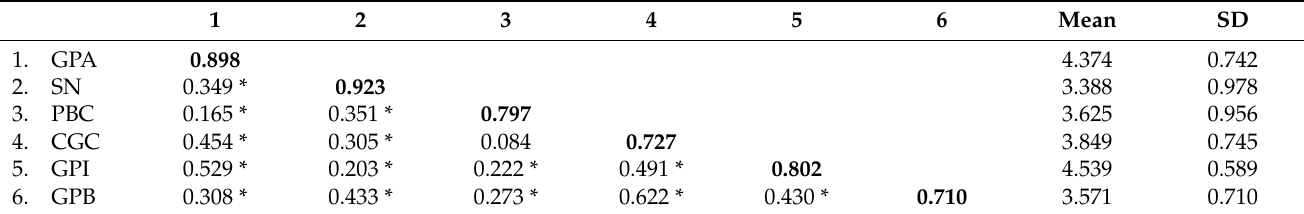
Table 3. Descriptive findings and correlations between latent